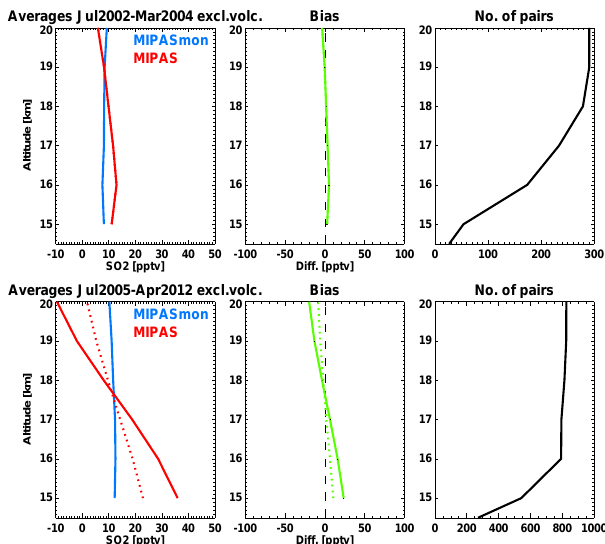
Figure 4. Comparison between monthly mean profiles from ACE- FTS, MIPASmon (Höpfner et al., 2013) and MIPAS. Left: average profiles (red solid: MIPAS original data set, red dotted: MIPAS data set after debiasing). Middle: mean differences (blue: MIPASmon – ACE-FTS, red: MIPAS – ACE-FTS, red solid: before debiasing, red dotted: after debiasing) together with their standard error (error bars; not visible in the top row since these are smaller than the line thickness). Right: number of collocated pairs of monthly mean val- ues used for comparison at each altitude. Top: only those pairs are selected where MIPASmon profile values are smaller than 50 pptv up to 20 km altitude. Bottom: only those pairs are selected where MIPASmon profile values are above 100 pptv at least at one altitude level up to 20 km.